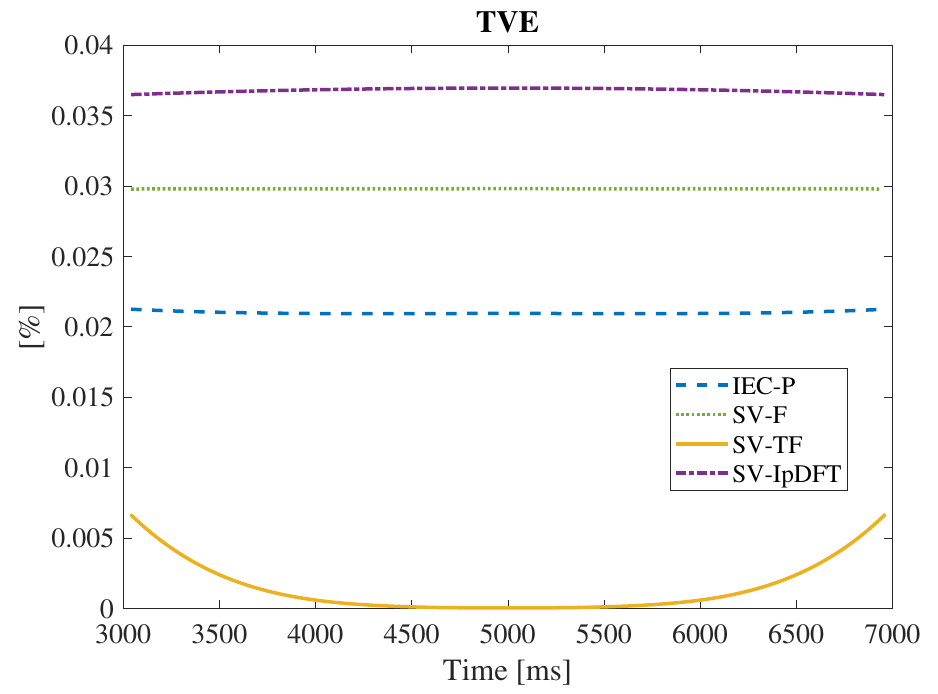
Figure 20. TVE as a function of time under frequency ramp